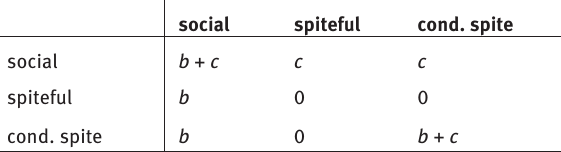
Table 3: The Prisoner’s Delight game with a conditionally spiteful strategy that only spites different types.